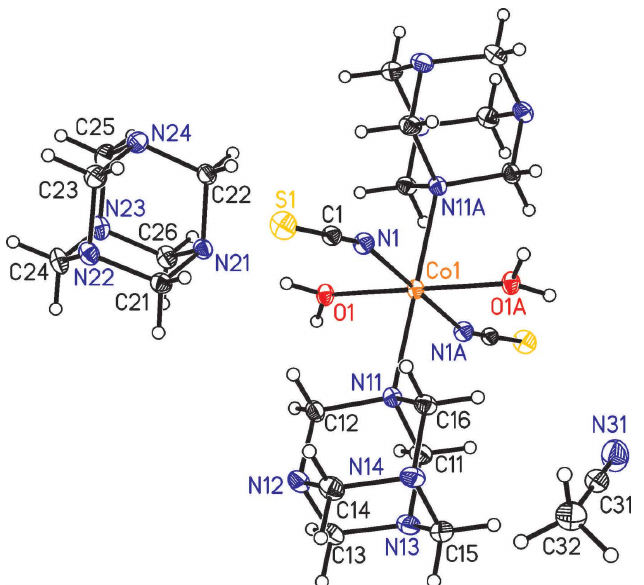
Figure 1 Crystal structure of the title compound with atom labeling and displacement ellipsoids drawn at the 50% probability level. Symmetry operation for the generation of equivalent atoms: (A) (cid:3) x + 1, (cid:3) y + 1, (cid:3) z +